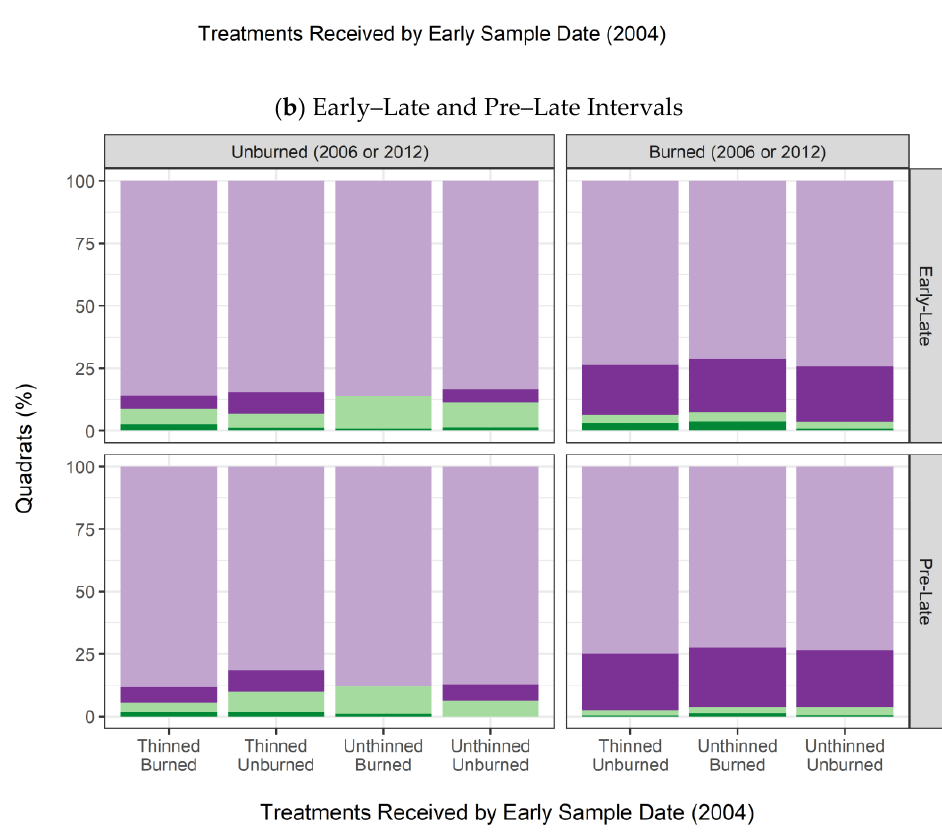
Figure 5. Percentage of quadrats displaying four types of seedling dynamics (absence, colonization, loss, or persistence) in the ( a ) Pre–Early and ( b ) Early–Late and Pre–Late intervals. Each quadrat was assessed for seedling presence / absence at the start and end of the interval. (cid:48) Absent (cid:48) represents quadrats that had no seedlings at either date. (cid:48) Colonization (cid:48) represents quadrats lacking seedlings at the start but with one or more seedlings at the end of the interval. ‘Loss’ represents quadrats with one or more seedlings at the start but no seedlings at the end of the interval. (cid:48) Persistence (cid:48) represents quadrats with one or more seedlings at both dates. See Section 2.3 for additional details. Note that no thinned plots experienced both Early and Late